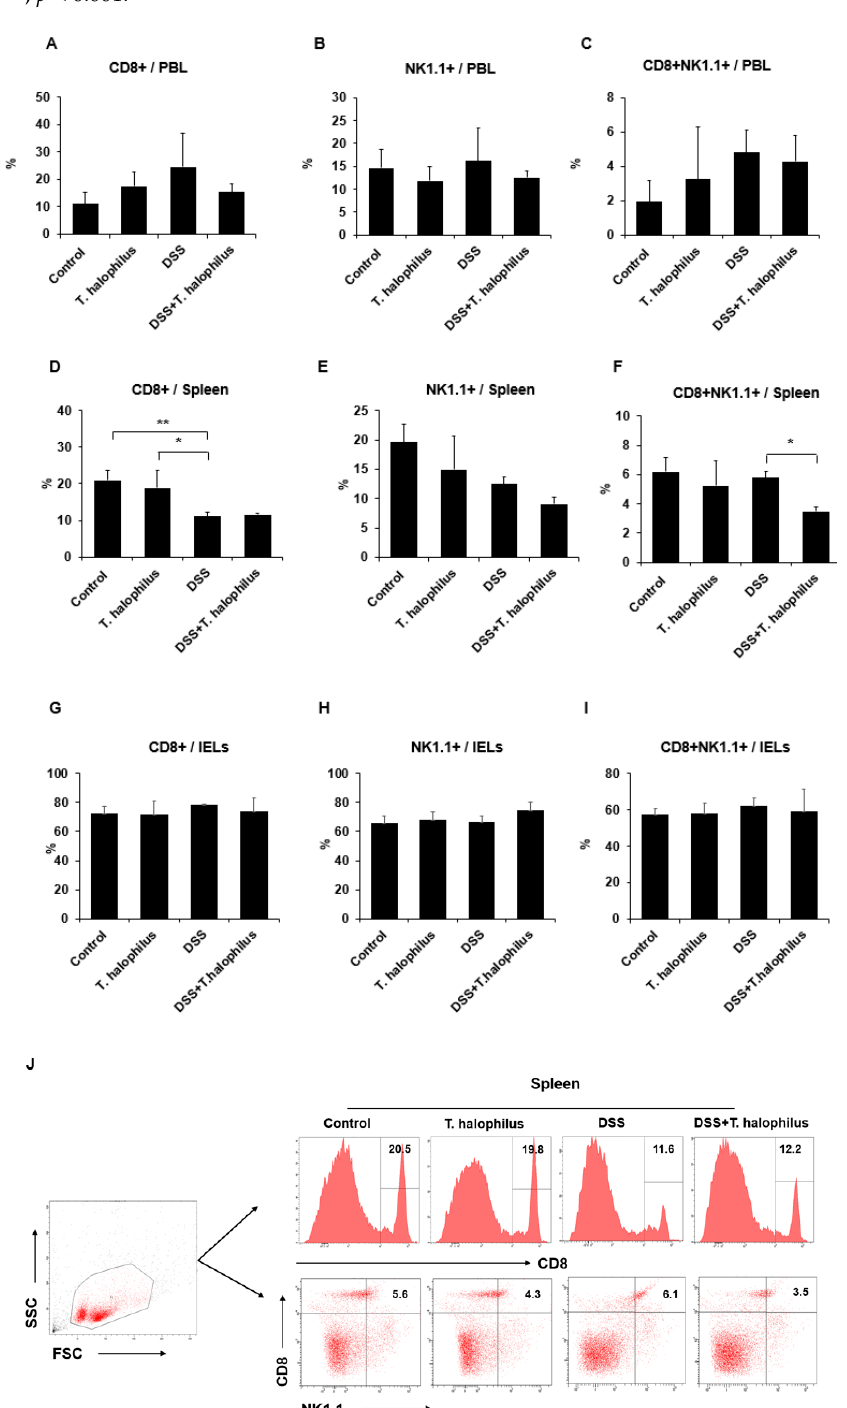
Figure 3. Effects of T. halophilus on the frequencies of CD8+NK1.1+ cells in DSS-induced colitis